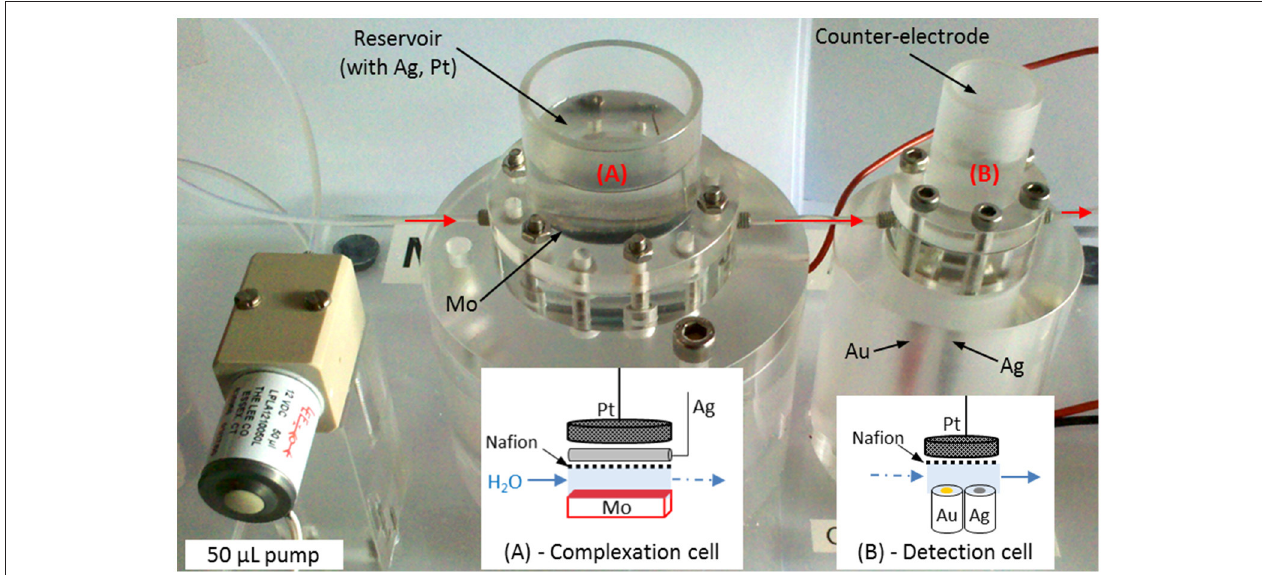
FIGURE 1 | Small volume prototype to detect silicate in seawater with on the left the solenoid Lee-Co ® pump, (A) complexation cell and (B) detection cell and the corresponding schematic representation of the electrodes.